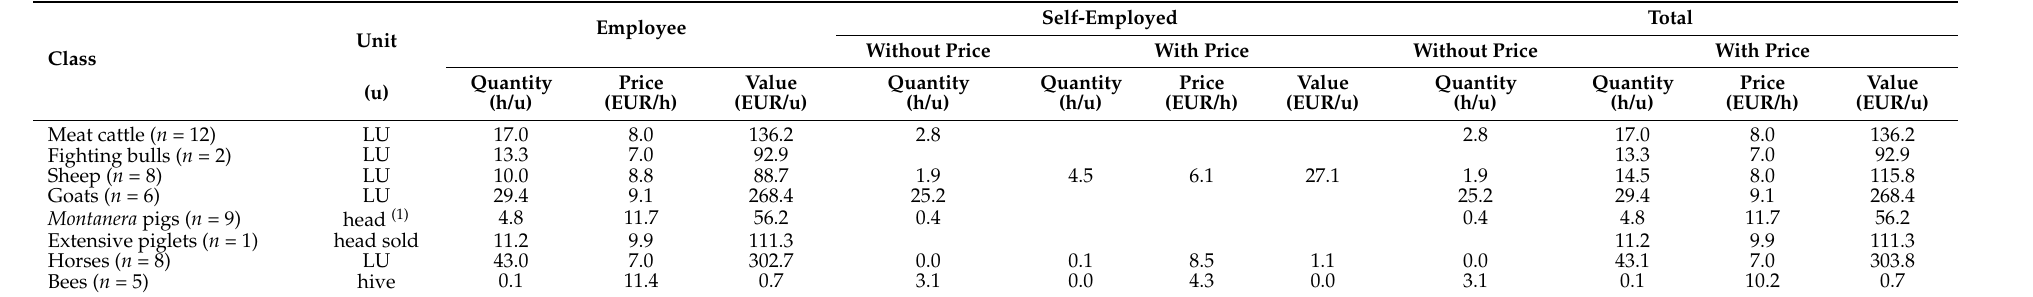
Table A2. Livestock species labor quantity, price, and value of large privately owned dehesas in Andalusia